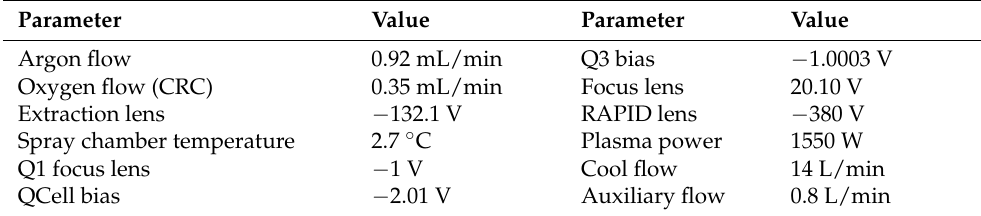
Table 3. Instrumental parameters of iCAP TQ